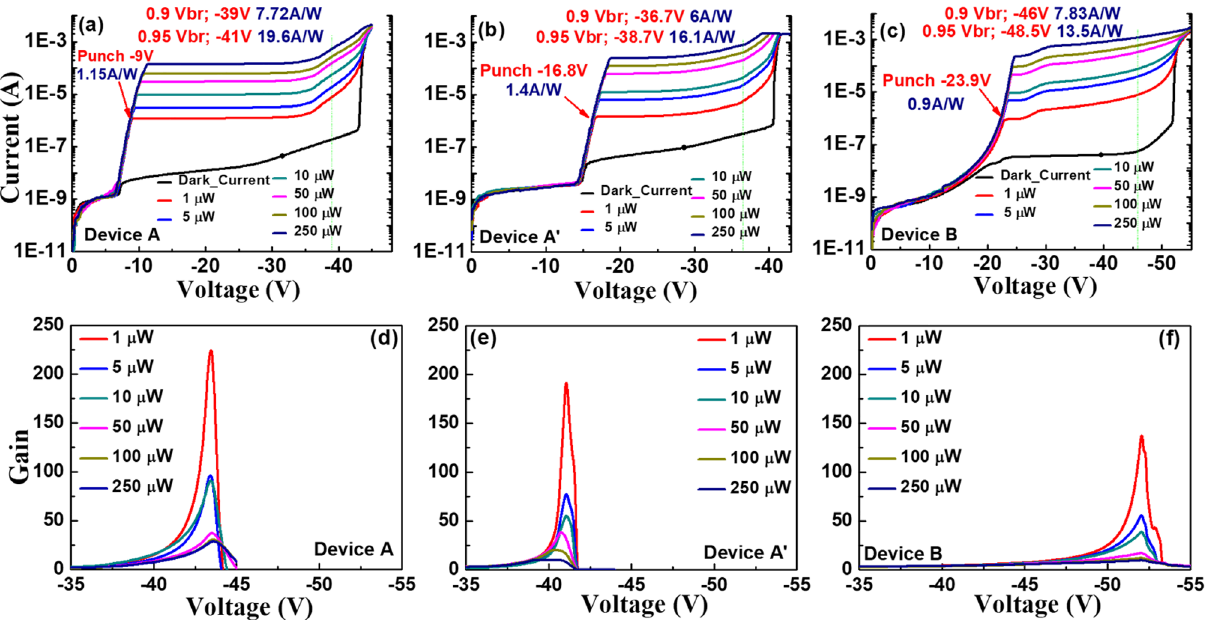
Figure 4. ( a – c ) shows measured bias dependent dark current and photocurrent ( d – f ) shows operation gain versus bias voltage under different optical pumping powers for Device A, Device A ′ and Device B, respectively.